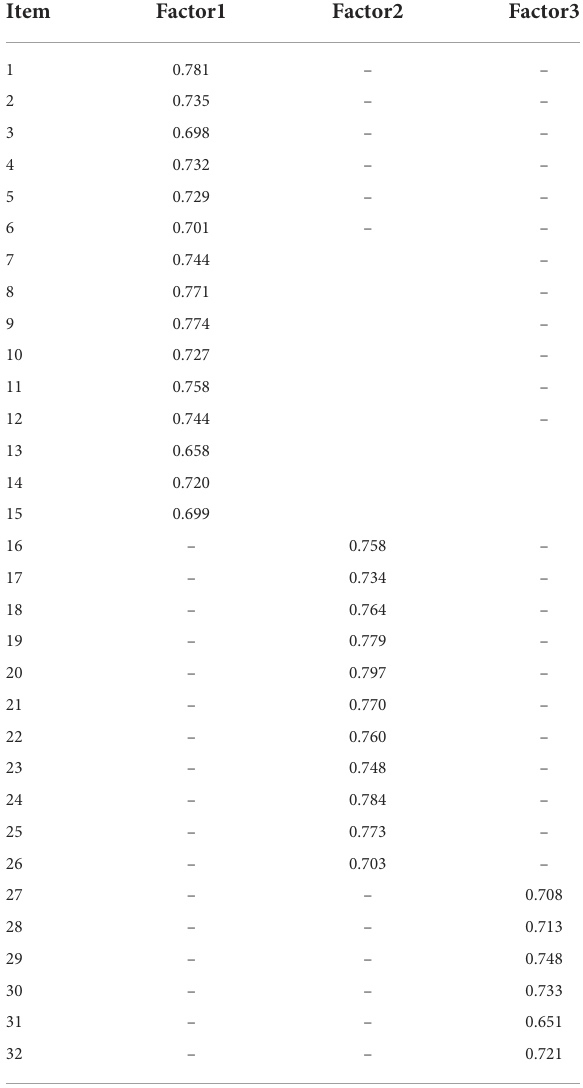
TABLE 4 Factor loadings of exploratory factor analysis for the healthy aging activity engagement